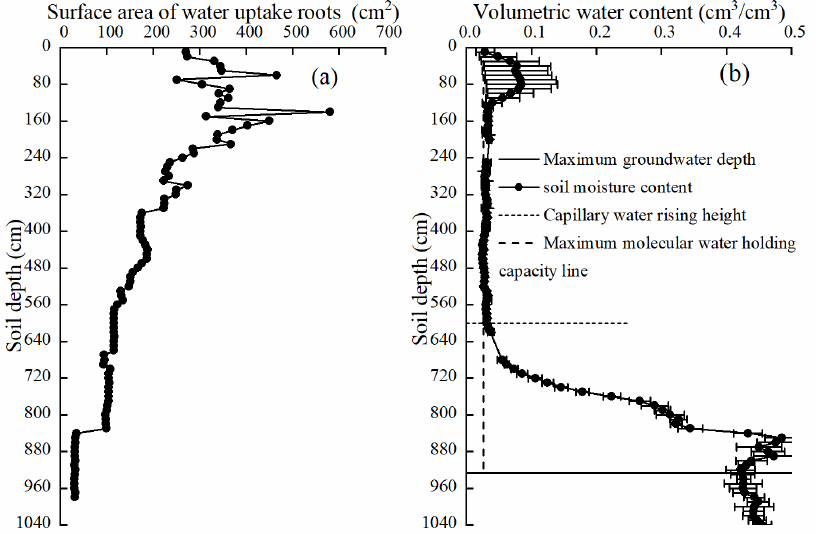
Figure 3. Distribution of the H. ammodendron root system in the test area.